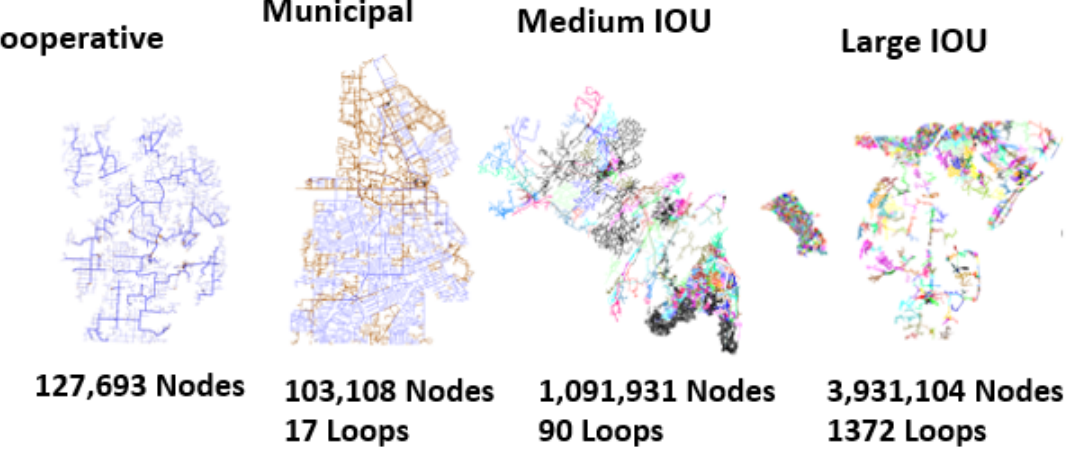
Figure A1. Examples of ISMs in production from across the industry. One of the major benefits of ISMs is the ability to automate calculations that run on the whole system. The co-operative ISM is used by an automated 8760 power flow (i.e., one power flow for each hour of the year), which employs hourly customer load data. One use of the municipal ISM is in a real-time simulation of a transmission system phase-shifting transformer, used to control power flow around the municipal’s transmission system. Note that the large IOU is split into two disjoint models. Both the medium and large IOUs use their ISMs in the automated analysis of PV applications and automated PV Hosting Capacity Analysis. There are approximately 6000 PVs modeled in the medium IOU, and 90,000 PVs modeled in the large